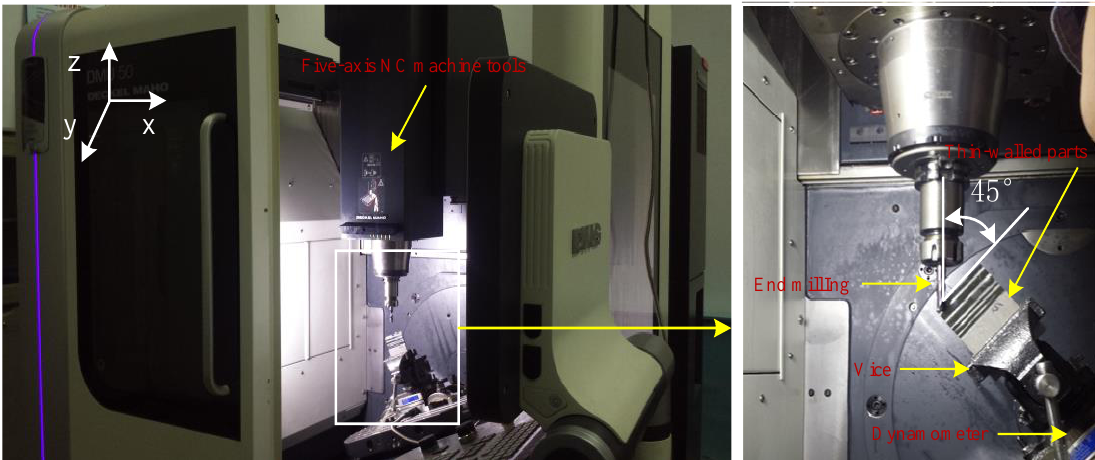
Figure 3. The experimental platform of variable cutting depth milling. Table 1. Tool parameters and material properties of Al6061. Tool Workpiece